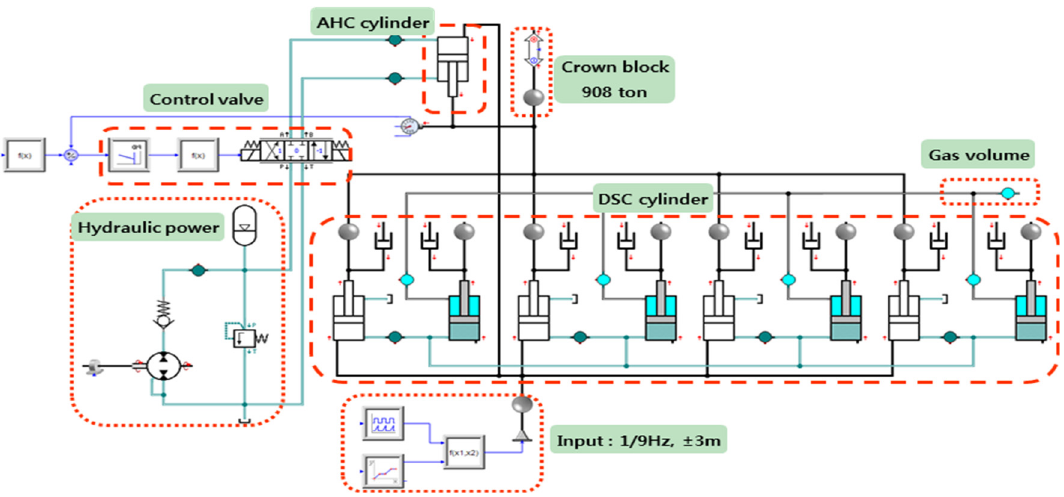
Figure 1. Simulation model of heave compensation system.